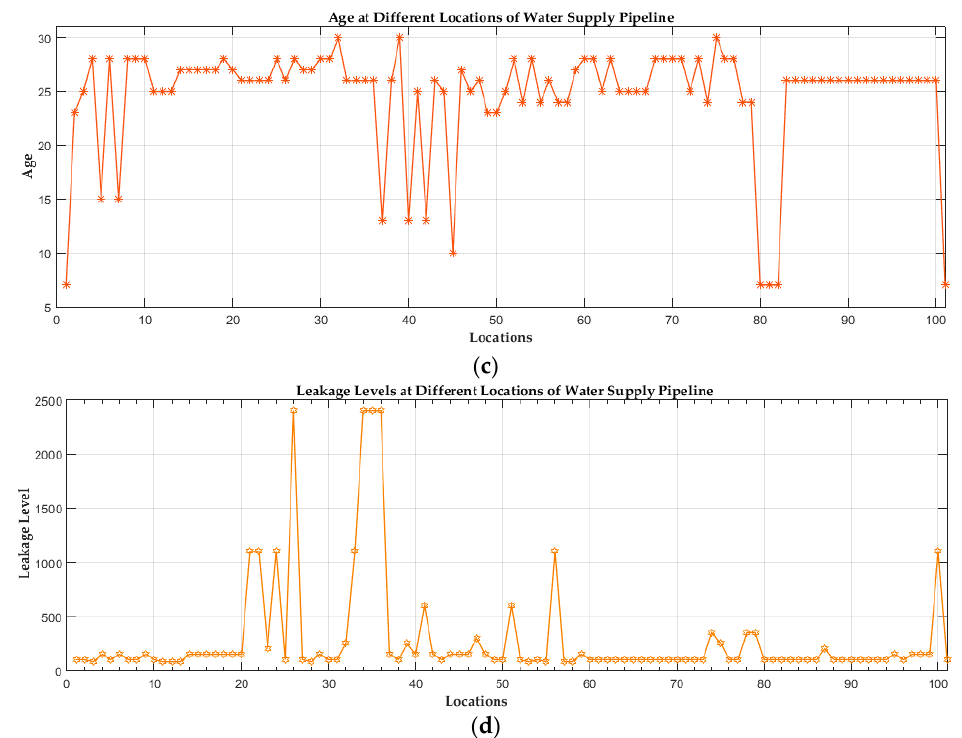
Figure 16. Graphical representations of input data: ( a ) depth; ( b ) length; ( c ) age; and ( d ) leakage.